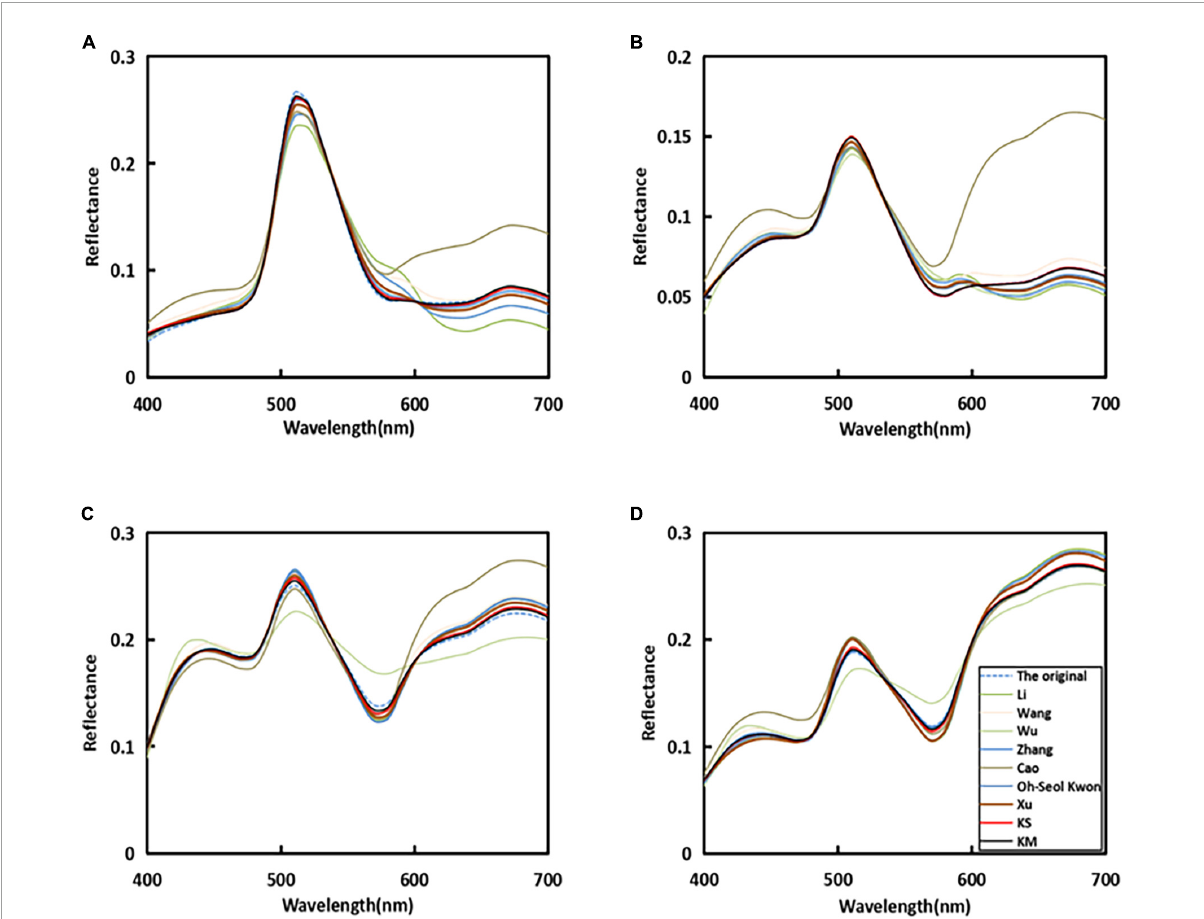
FIGURE5 Reflectance recovery results from the proposed and existing methods with four randomly selected samples in the simulated experiment.